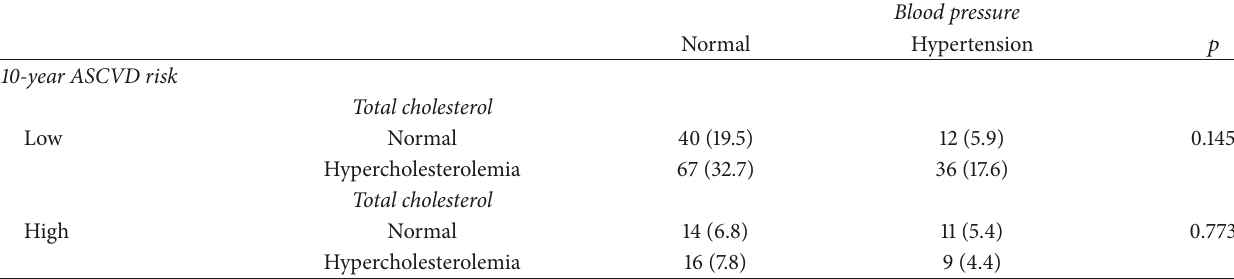
Table 2: Association between CVD risk factors in coffee harvesters.